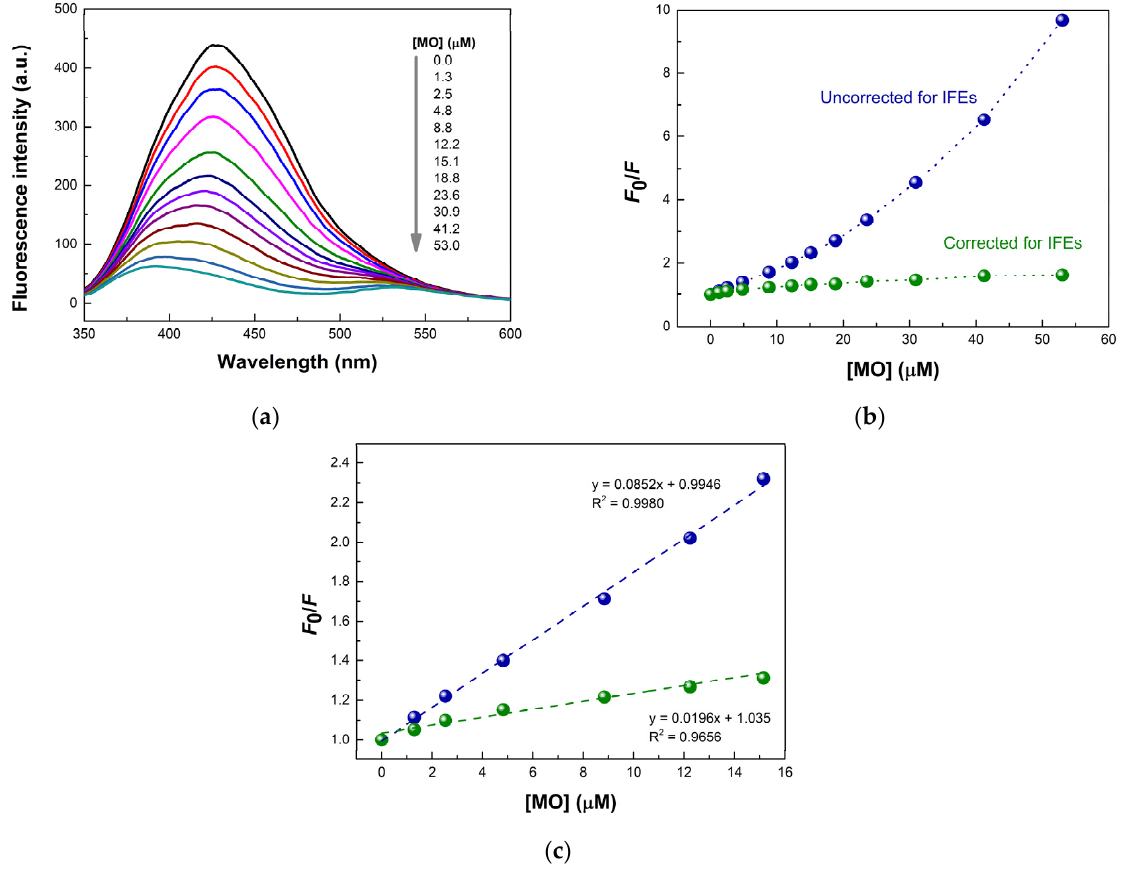
Figure 6. ( a ) Emission spectra of WP-CDs (0.1 mg/mL) on titration with MO (0.0–53.0 µ M) in phosphate buffer (pH = 7.2) at 25 ◦ C. ( b ) Uncorrected (blue dots) and corrected (green dots) plots showing the observed fluorescence intensity behavior of WP-CDs-MO system at the full concentration range of MO (dotted lines drawn as an eye guide). ( c ) Stern-Volmer plots obtained from uncorrected fluorescence intensities (blue dots) and after correction for IFEs (green dots), up to [MO] = 15.1 µ M. Steady-state data acquired under excitation at 340 nm and 426 nm observation.